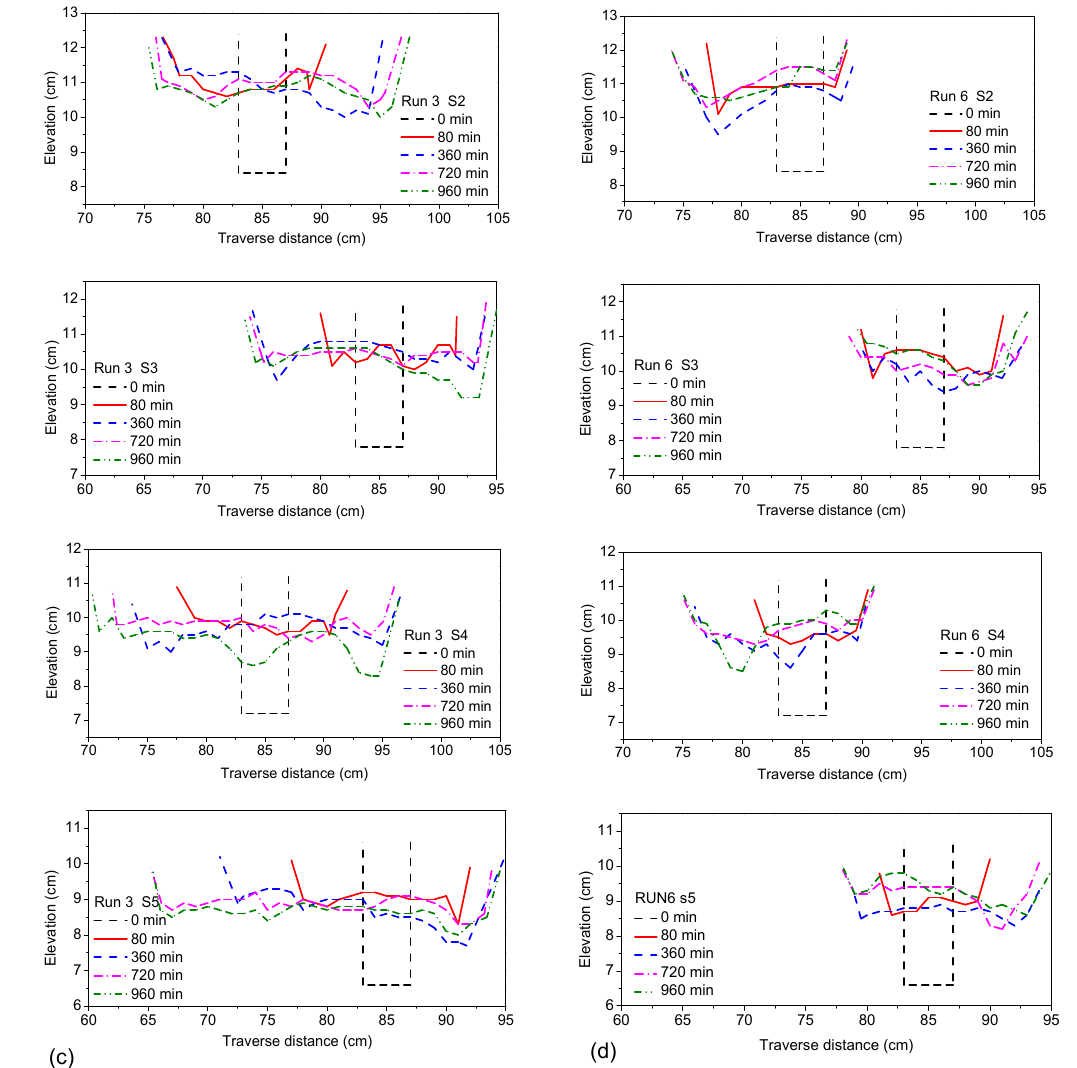
Figure 16. Evolution of the cross-section during four experimental runs: ( a ) Run 1, ( b ) Run 5, ( c ) Run 3 and ( d ) Run 6. Flow direction points to the observer.